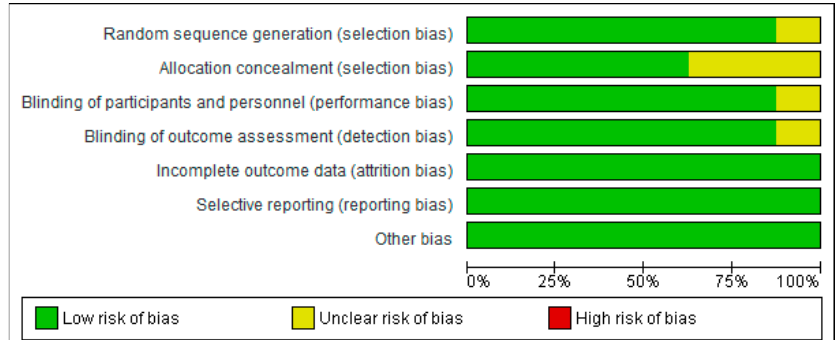
Figure A1. Risk of bias graph: review authors’ judgements about each risk of bias item presented as percentages across all included studies.